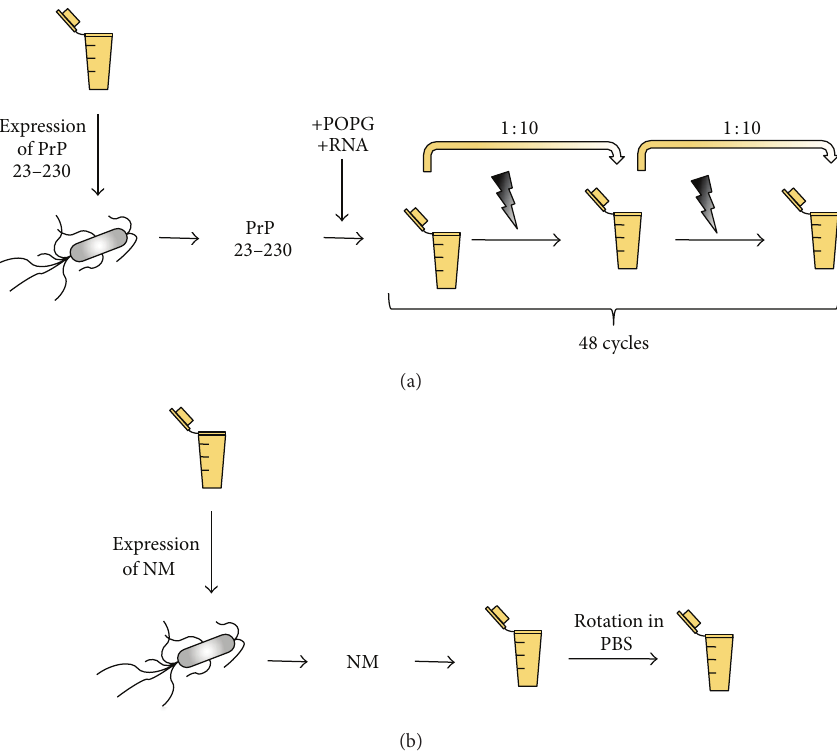
Figure 3: Generation of infectious protein polymers from minimal components in vitro. (a) For the generation of infectious PrP aggregates, purified recombinant murine PrP comprising amino acid residues 23 to 230 is mixed with lipid POPG and total liver RNA or synthetic polyA RNA. In a so-called protein misfolding cyclic amplification reaction (PMCA), intermittent pulses of sonication shear aggregates and increase the number of seeds. Preformed seeds are subsequently elongated and fragmented by serial dilution of samples into a new reaction buffer (supplemented with recombinant PrP and cofactors) and PMCA. Synthetic prions generated by this method have been shown to chronically infect SN56 and CAD cells [8, 62]. (b) The formation of Sup35 NM fibrils does not require additional cofactors. Purified recombinant NM is diluted to a concentration of 10 𝜇 M in phosphate buffered saline and left at room temperature overnight. Formation of NM fibrils is expedited by agitation. Addition of these fibrils to N2a cells stably expressing soluble NM induces a heritable NM prion phenotype [57,